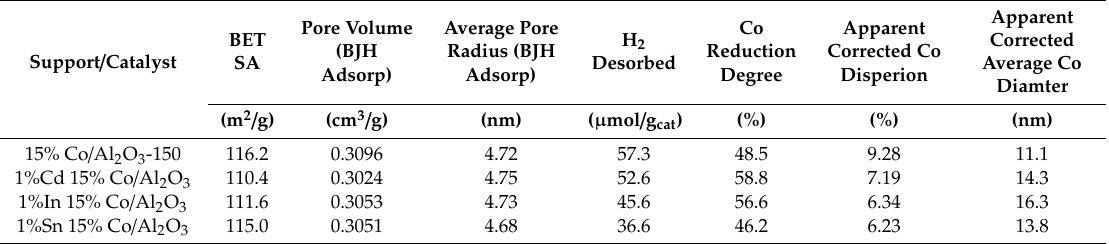
Table 1. Results of BET surface area and H 2 chemisorption pulse